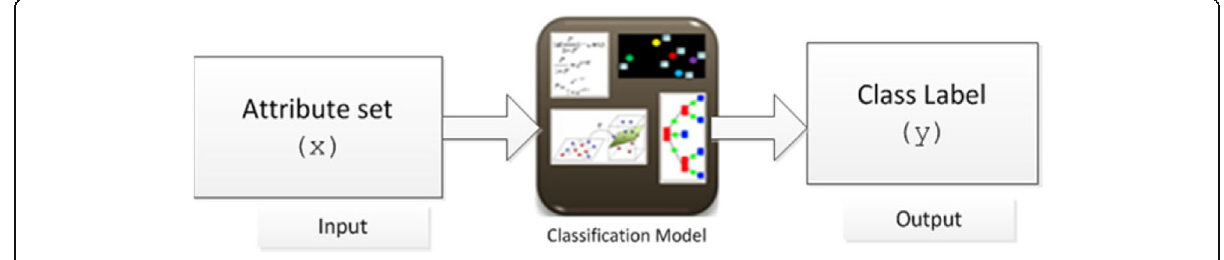
Fig. 4 Classification as the